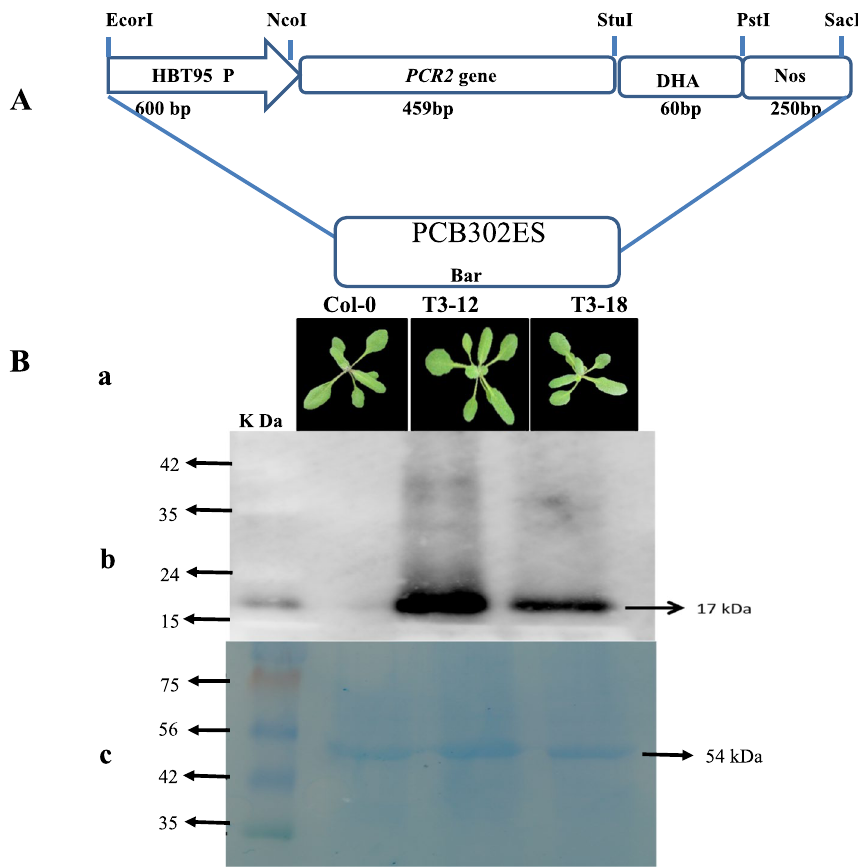
Fig. 6 A Plant transformation vector construction with restriction sites. B a Col-0 and transgenic lines (Col-0, T3-12, and T3-18) grown at normal conditions; b Lane B contains Western blot of Col-0, T3-12, and T3-18 (overexpressed PCR2 protein-detected 17kDa with HA-tagged antibodies); c Line C contains SDS-PAGE of the Col-0, T3-12, and T3-18 (Rubisco protein 54